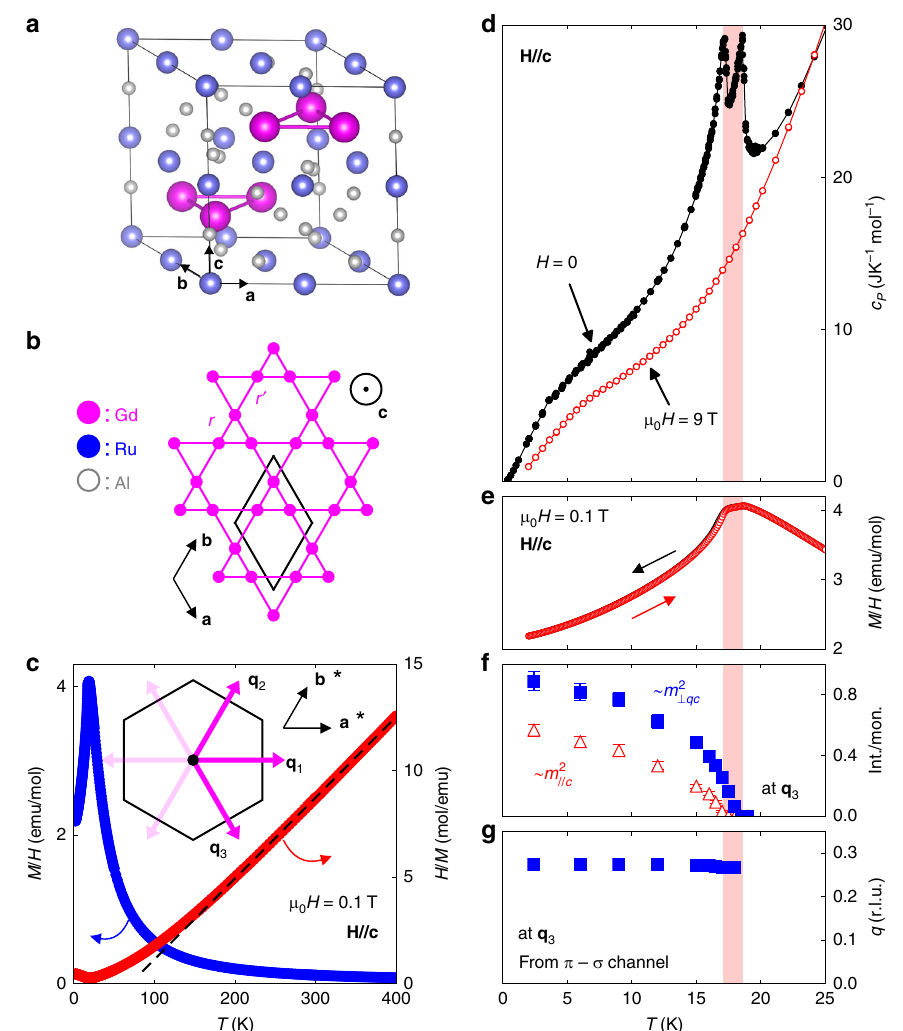
Fig. 1 Crystal structure and zero- fi eld magnetic order of a Gd-based breathing kagomé lattice. a Hexagonal unit cell of Gd 3 Ru 4 Al 12 , where a , b , and c are crystallographic lattice directions. b Within the Gd 3 Al 4 layer, rare earth (Gd) atoms form a distorted kagomé net with alternating distances r , r ’ between nearest neighbors. Al and Ru atoms are not shown. The black rhombus indicates the size of the primitive unit cell. c Magnetic susceptibility (blue, left axis) increases continuously in the paramagnetic state as temperature is lowered. The inverse susceptibility H / M (red, right axis) is fi tted by the Curie – Weiss expression (dashed line) at high temperature. d , e Speci fi c heat c P ( T ) and M / H show two phase transitions in zero magnetic fi eld. f , g At the (7, 0, 0) + q 3 = (7 + q , − q , 0) incommensurate re fl ection, resonant x-ray scattering with polarization analysis provides modulated moments within ( m ⊥ q,c , blue solid triangles) and perpendicular to ( m //c , red open triangles) the hexagonal plane, as well as the magnitude of the ordering vector q . Inset of ( c ) six directions of q i are allowed by symmetry. The black hexagon indicates a conventional unit cell in real space. The transition temperatures T N2 > T N1 bound the red shaded area in ( d – g temperature-hysteretic Hall conductivity signal (shaded in gray) divergence between the ZFC and FC curves at T = 5 – 8 K in emerges on the back of a smooth background in an intermediate Fig. 2d marks the fi rst order phase transition between the TC and range of magnetic fi elds. We approximate the background by a SkL states in our phase diagram (labeled in Fig. 2a,c by black open low-order (odd) polynomial and extract the topological Hall squares). Detailed susceptibiltity measurements evidence that the conductivity σ xy THE . The topological signal as obtained from the boundaries of phases TC and SkL with all surrounding phases are isothermal fi eld scans is con fi ned within the boundaries of the also strongly of fi rst order (Supplementary Fig. 7). SkL phase (Fig. 2c). Meanwhile, measurements of σ xy ( T ) at fi xed magnetic fi eld and for increasing temperature (d T /d t > 0) show a large split between curves recorded under zero- fi eld cooled (ZFC) and fi eld-cooled (FC) sample conditions, exclusively at inter- mediate fi eld values (Fig. 2d, μ 0 H int = 1.22 and 1.42 T). The natural conclusion is that a metastable SkL state, with its largely enhanced σ xy ( T ), can be sustained at the lowest temperatures in in REXS, three mutually orthogonal components of the the FC experiment, where the SkL is absent under ZFC conditions. This behavior suggests the stabilization of the SkL by thermal fl uctuations (c.f. Discussion section). The point of